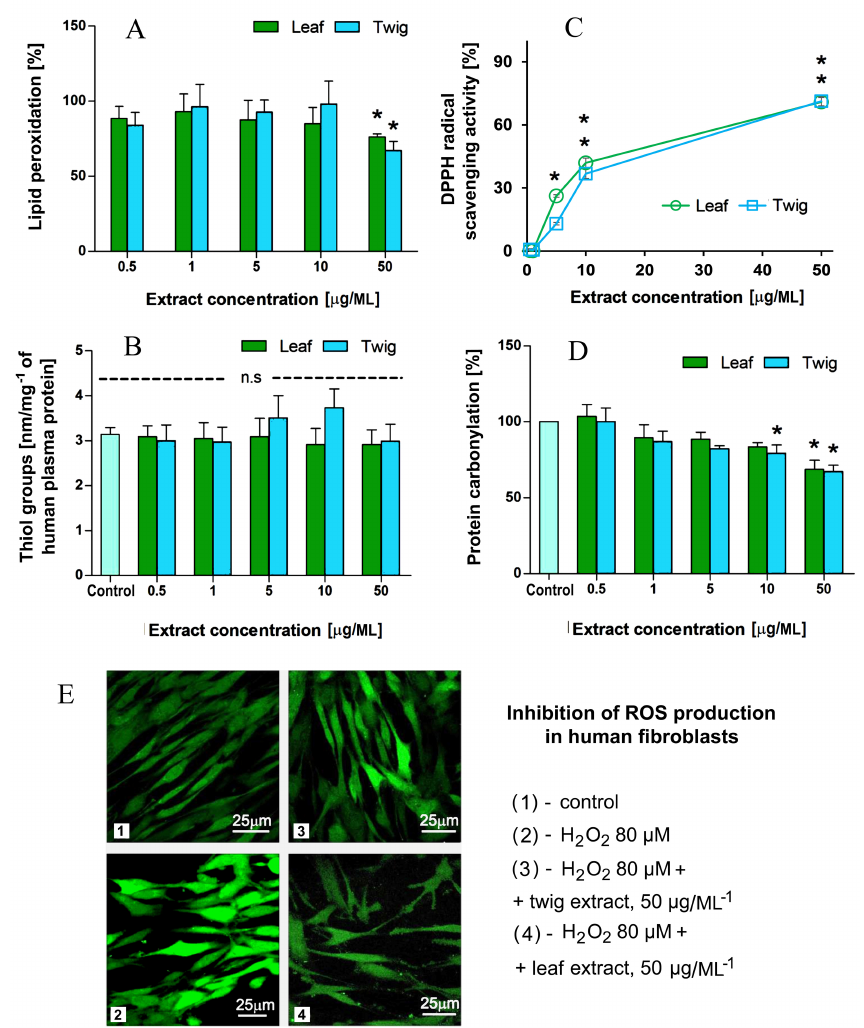
Figure 4. E ff ect of the R. canina twig and leaf extracts (0.5–50 µ g / mL − 1 ) on H 2 O 2 / Fe-induced plasma lipid peroxidation ( A ); oxidation of thiol groups ( B ); percentages of DPPH free radical scavenging ( C ); protein carbonylation ( D ). Confocal microscopy images of BJ cells after 24 h incubation with the extracts. ( E ) 1—control; 2—H 2 O 2 80 µ mol / L; 3—H 2 O 2 + twig extract 50 µ g / mL − 1 ; 4—H 2 O 2 + leaf extract 50 µ g / mL − 1 . Scale bar = 25 µ m. The data are mean ± SEM ( n = 3). * p < 0.05 vs. control. Ns—not statistically